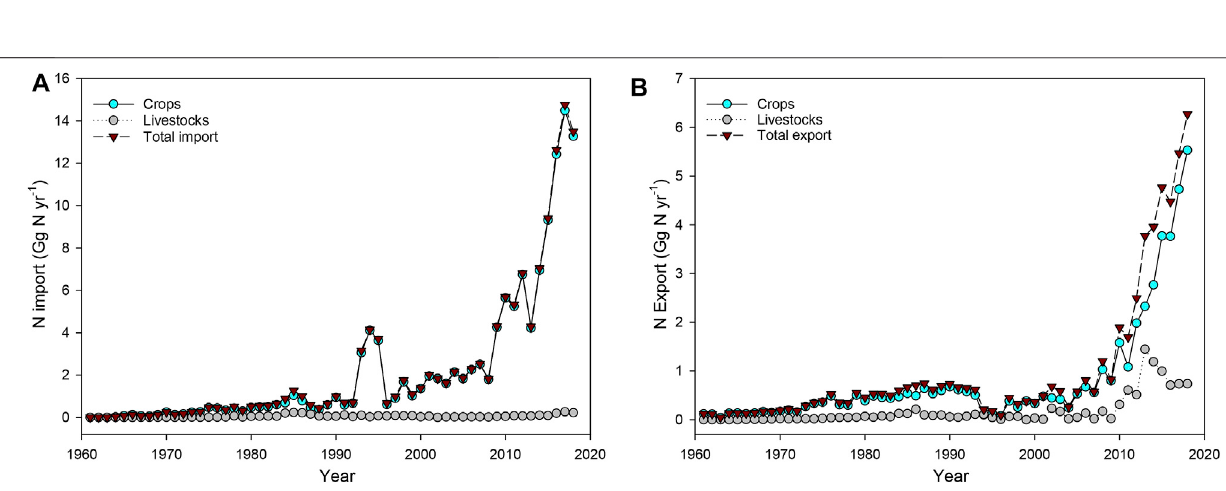
FIGURE 3 | Historical changes in import (A) and export (B) of crop and livestock